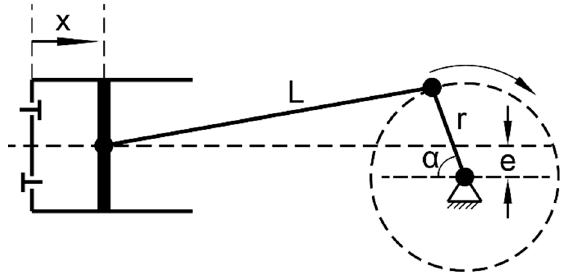
Figure 6. Schematic diagram of the refrigerator compressor.